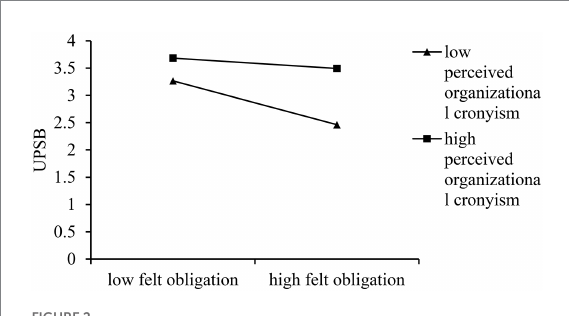
FIGURE 2 The moderating effect of perceived organizational